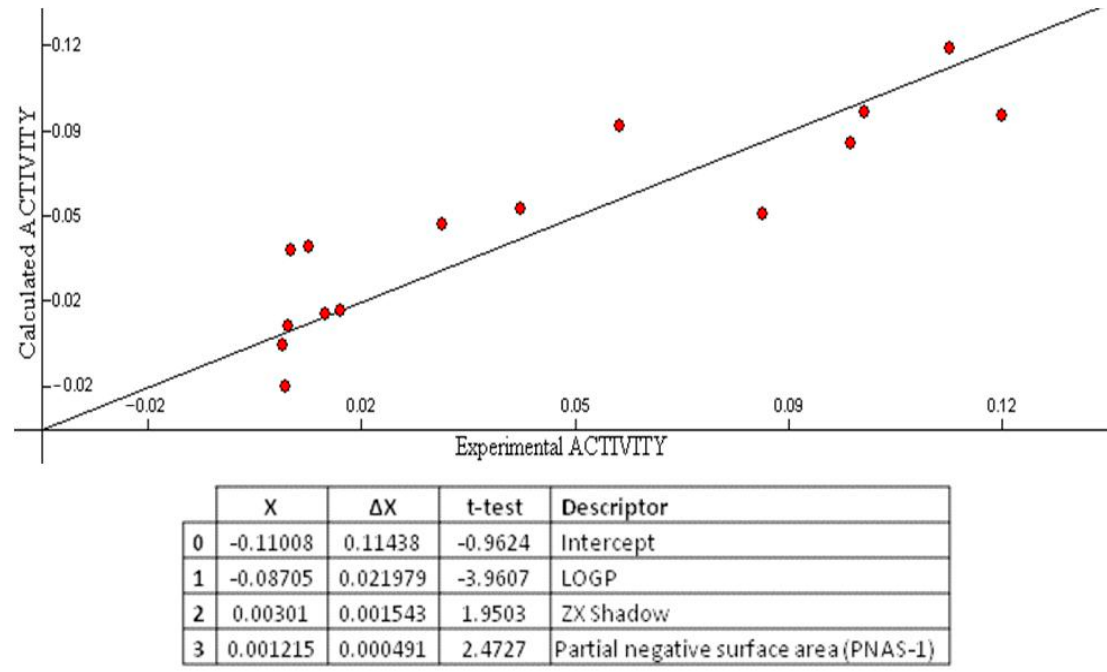
Figure 6. QSAR model obtained with the heuristic method for 15 chalcones with the CODESSA software ( R 2 = 0.7446, F = 10.69, and s = 0.0006). X, ∆ X and t-test are the regression coefficient of the linear model, standard errors of the regression coefficient, and the t significance coefficient of the determination, respectively.